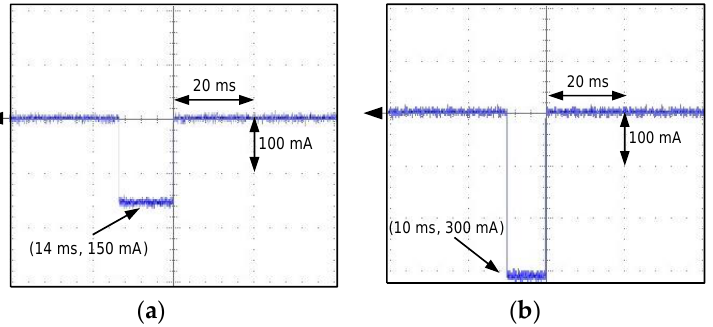
Figure 22. Tripping of the two 30 mA F-type RCDs: (RCD30_4) and (RCD30_5) (the same responses for these two RCDs) for a pure direct current (suddenly applied) of values 15, 20, 30, 60, 90, 150, 300 and 600 mA.